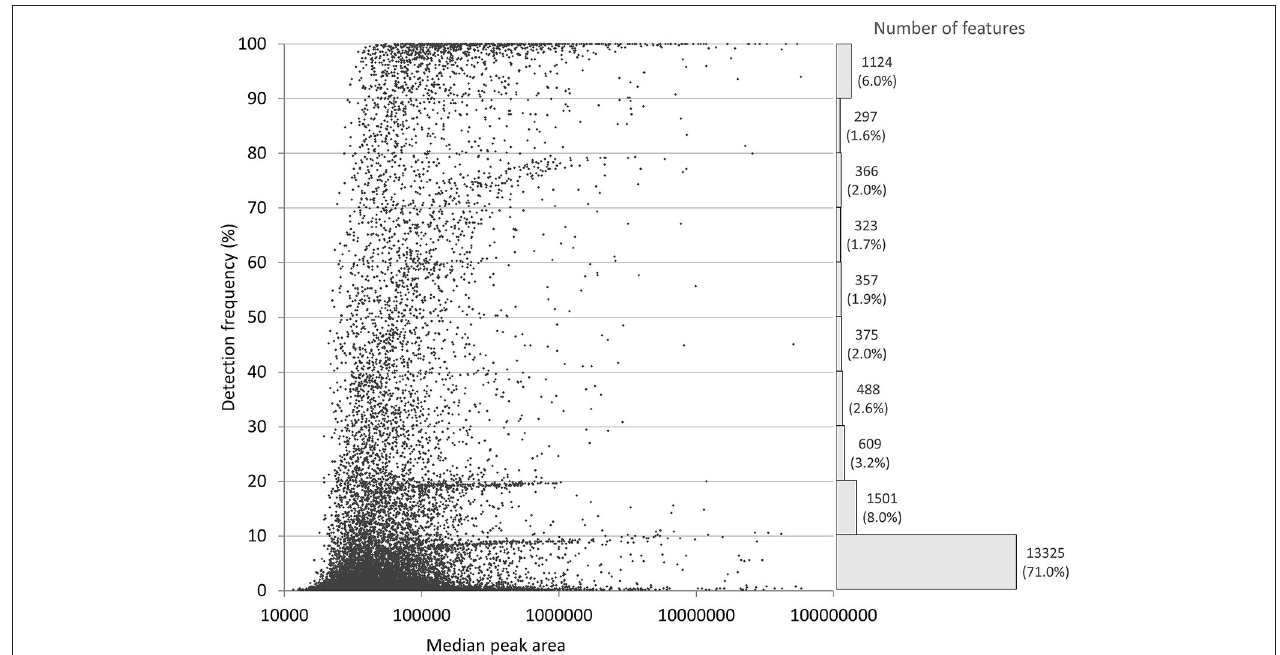
FIGURE 1 | Distribution of the 18,766 features with a peak height above 10,000 in our original study, before filtering on detection frequency (2). Detection frequency refers to the percentage of samples where the feature was detected. The histogram shows the number and relative frequency of features per each 10%